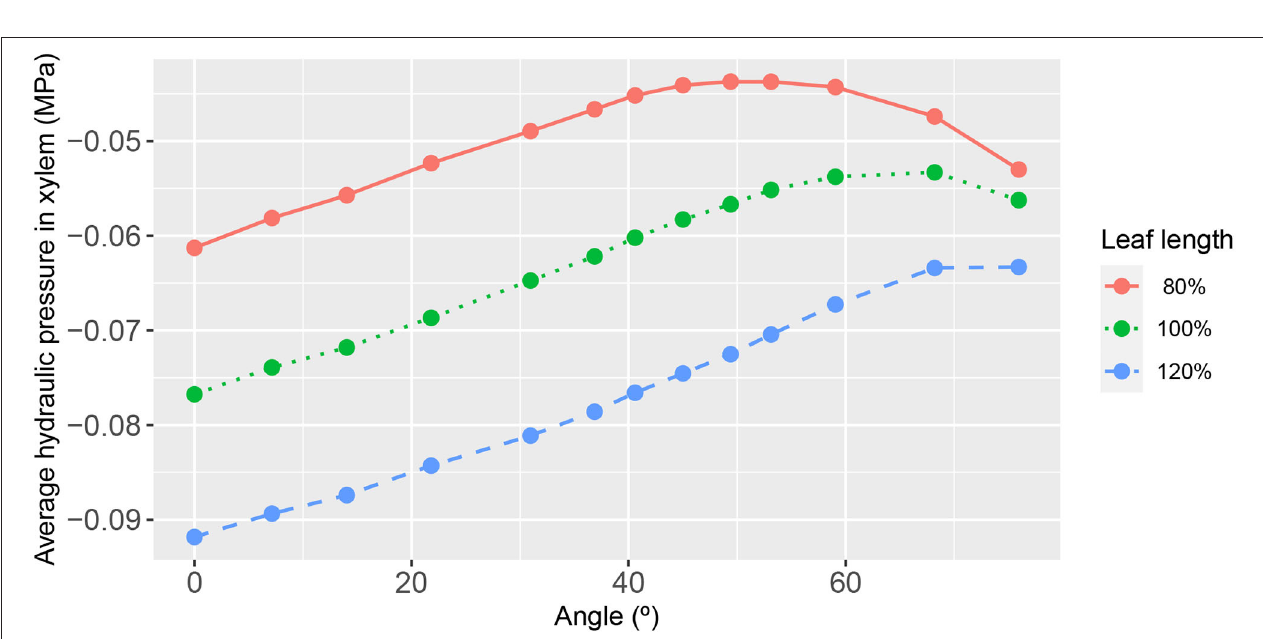
FIGURE 10 | The functional relationship between leaf area-average, xylem hydraulic pressure, and second-order vein angle. Curve descriptions and simulation conditions are as in Figure 7 except with a uniform second-order vein conductance of K xyl = 100 K ph / 3 = 1 × 10 − 4 mmol s − 1 m − 2 (i.e., a factor of one-fifth that of the core value).